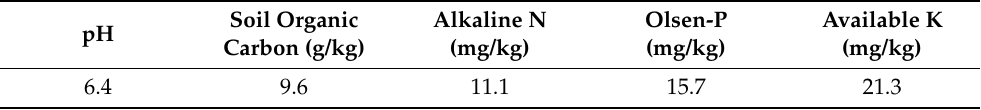
Table 1. Physicochemical characteristics of the